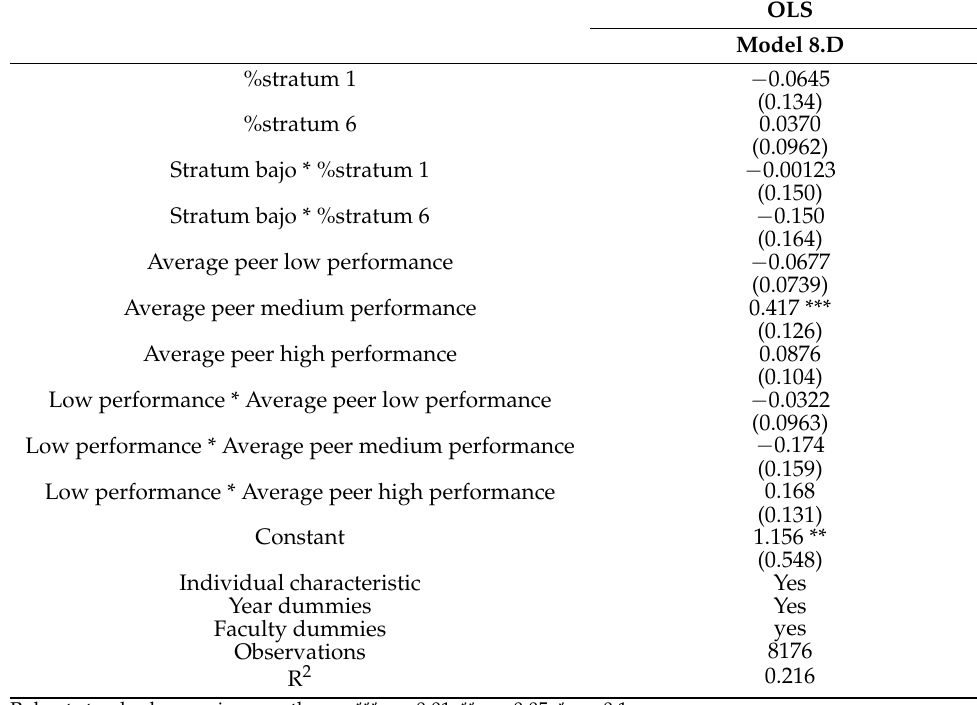
Table A4. Effects of heterogeneous peers according to the students’ socioeconomic level in Calculus